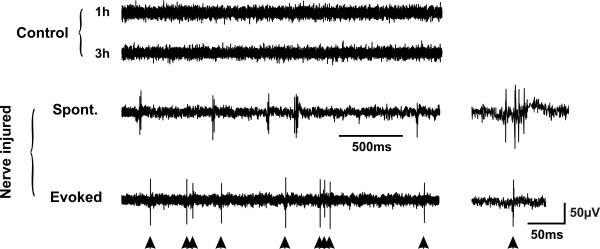
Occurrence of spontaneous bursts of activity in lamina I projection neurons following nerve injury. Continuous records showing an example of an epoch with spontaneous bursts of activity occurring in lamina I projection neurons after nerve injury (6 out of 8 where ongoing activity was measured over a sufficiently long period to obtain a quantitative measure). The bursts were characterized by spikes arising on top of a slower wave, which contrasted with the evoked activity in response to touch (lower trace; arrowheads indicated touch stimuli). Such bursts were virtually absent in control animals even after several hours of recording. The insets on the right show examples of spontaneous and evoked activity on a faster time scale.